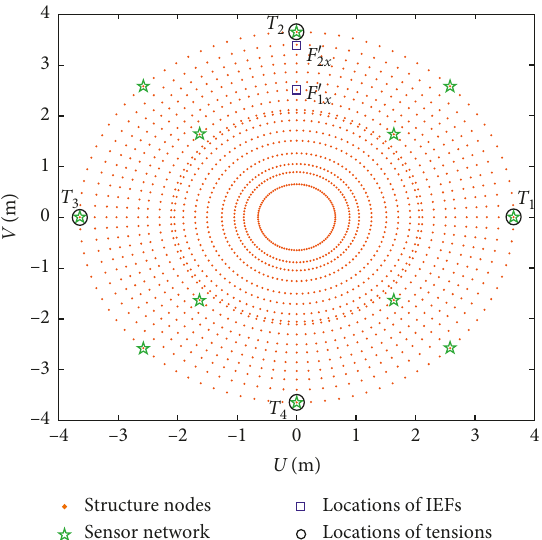
Figure 8: A network of structure nodes, sensors, and action points of IEFs and tensions.